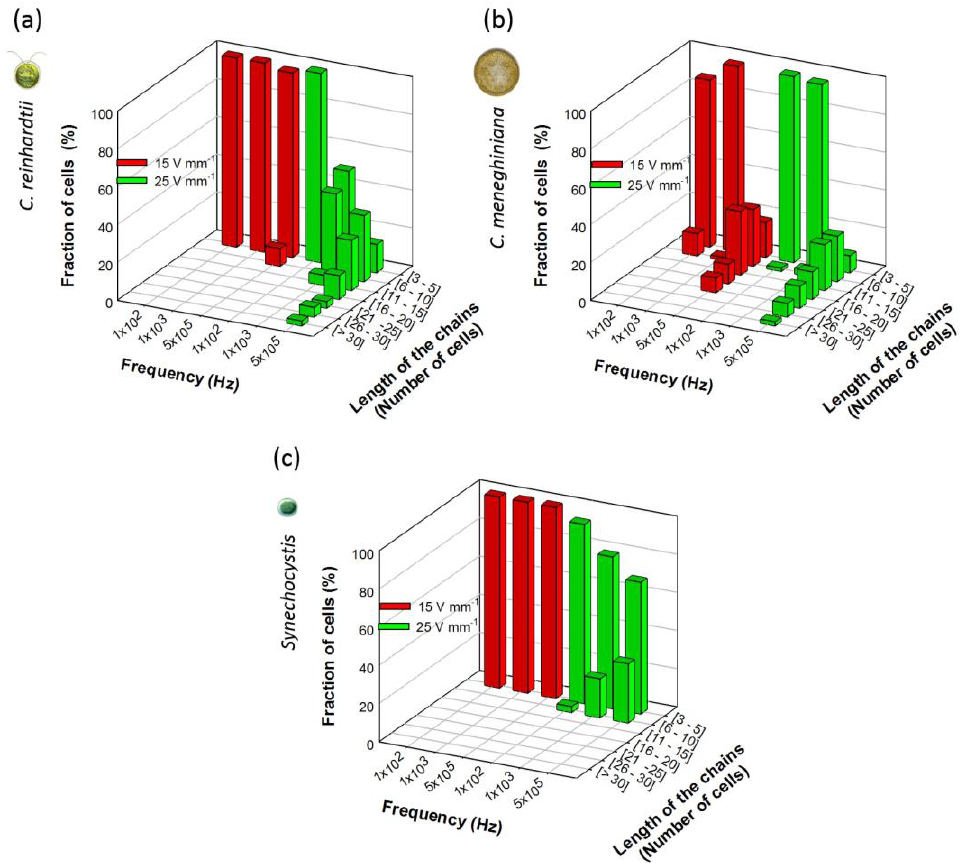
Figure 2. Length of the chains obtained at 15 and 25 V·mm −1 for 100 Hz, 1 kHz and 500 kHz for: ( a ) C. reinhardtii ; ( b ) C. meneghiniana ; and ( c ) Synechocystis sp. C. reinhardtii and C. meneghiniana initial concentrations: 5 × 10 6 cells·mL −1 ; Synechocystis sp.: 5 × 10 7 cells·mL −1 .